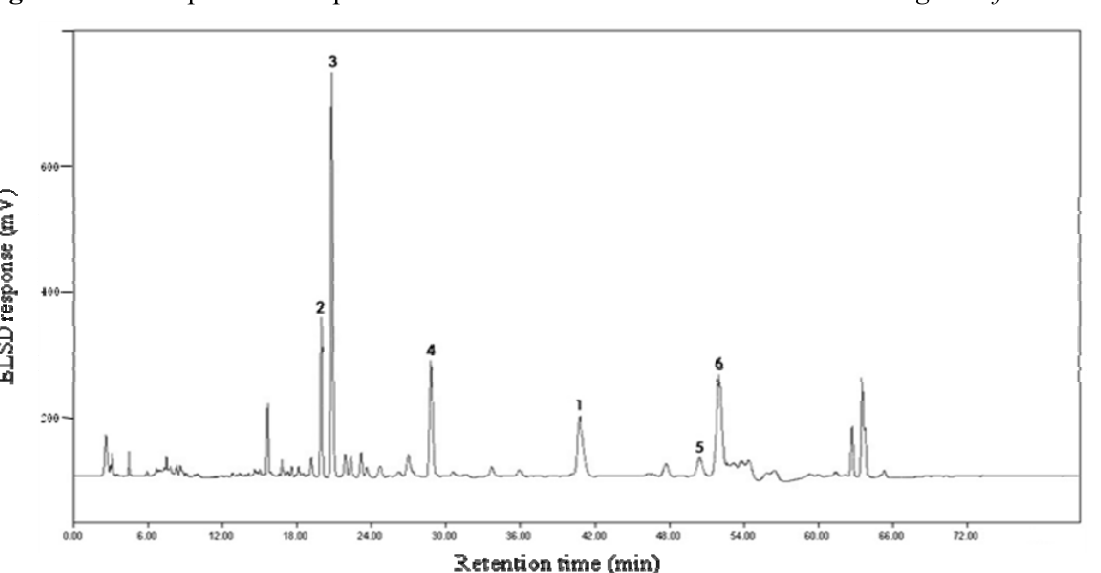
Platyconic acid A ( 1 ), deapioplatycoside E ( 2 ), platycoside E ( 3 ), platycodin D ( 5 ) and platycodin D ( 6